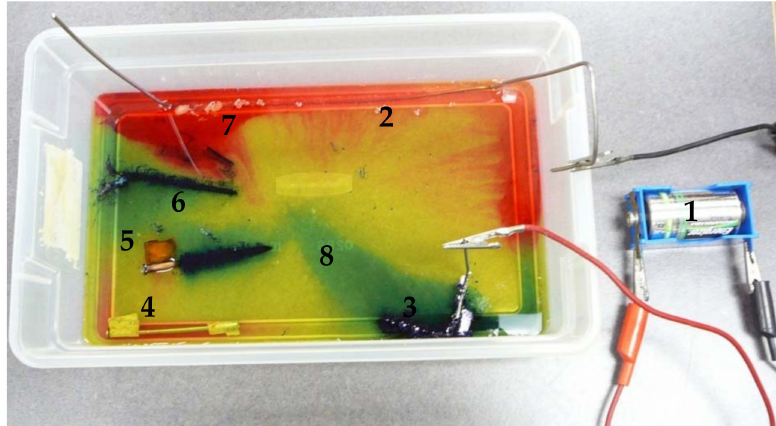
Figure 1. Illustration of corrosion and cathodic protection systems. Legend: 1. DC power supply for cathodic protection by impressed current; 2. iron structure to be protected; 3. scrap auxiliary anode; 4. cathodic protection by sacrificial zinc anode; 5. corrosion by galvanic coupling, Fe-Cu; 6. corrosion by local action cells; 7. cathodic areas, red color, reaction 2H 2 O + 2e → H 2 + 2OH − or O 2 + 2H 2 O + 4e → 4OH − ; 8. anodic areas, Prussian blue color due the interaction of Fe 2+ with [Fe(CN)